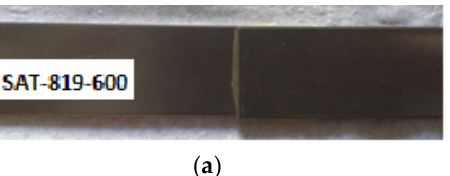
Figure 7. Photos of ( a ) Al/SAT-819-600/Al (slight adhesive outflow) and ( b ) Al/SAT-TPO-800/Al overlap joints (significant adhesive outflow).